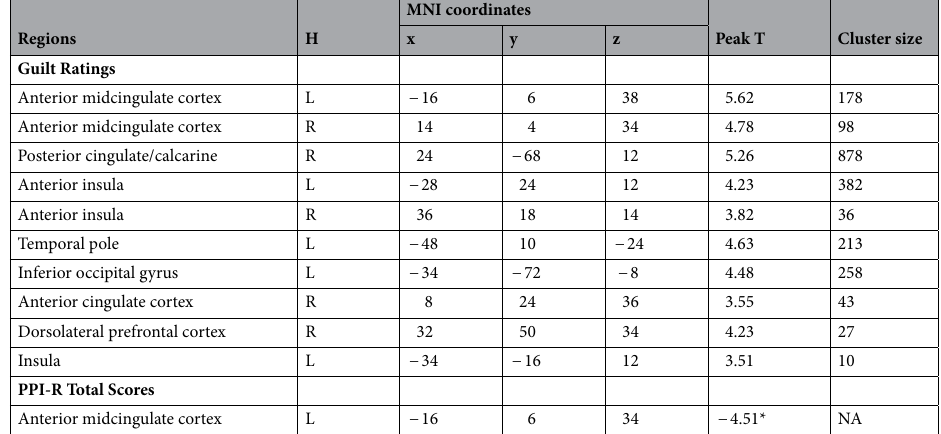
Table 4. Neural activations (harming vs. neutral) correlated with guilt and psychopathic traits from harming > neutral contrasts. Pooled group results (N = 56). All reported clusters significant at the FWE- corrected P < .05 level unless marked with an asterisk, which were taken from pre-defined regions of interest (ROIs) and significant at uncorrected P < .05. Negative and positive peak T-values represent negative and positive correlations, respectively. H, hemisphere; MNI, Montreal Neurological